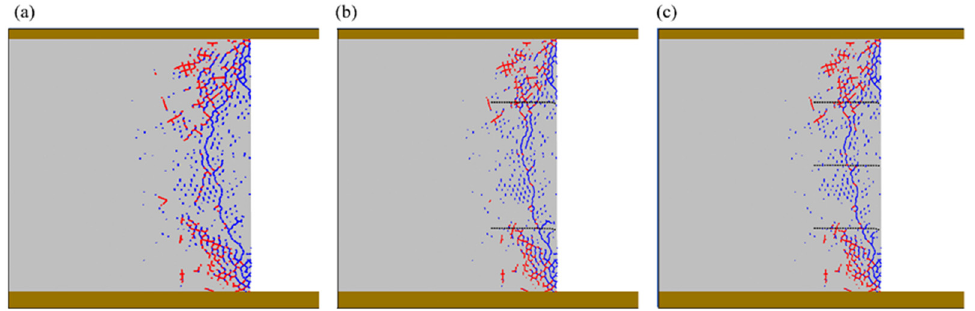
Figure 15. Rib damage profile in terms of the contact failure state. ( a ) Unsupported; ( b ) 2-cable-bolted rib; ( c ) 3-cable-bolted rib at overburden depth of 250 m and contact strength reduction of 1.60.